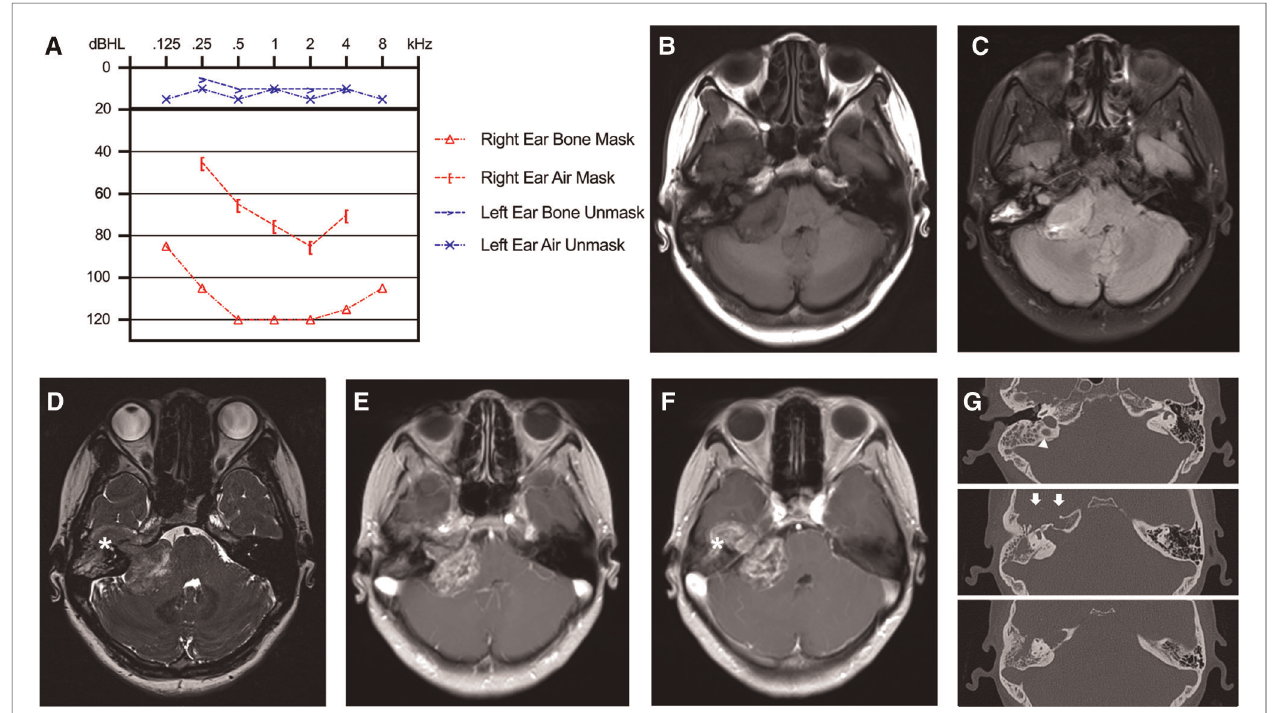
FIGURE 1 | Preoperative hearing and imaging scans. ( A ) Preoperative pure tone threshold audiometry demonstrated profound mixed hearing impairment of the right ear. ( B – F ) MRI scan revealed a mass with a maximal diameter of 5.0 cm at the right cerebellopontine angle with petrous bone invasion. The lesion exhibited low- to iso-intense on T1-weighted images ( B ), iso- to high-intense on T2-FLAIR images ( C ), mixed intense on constructive interference in steady state (CISS) images ( D ), and heterogeneously enhanced after Gd-DTPA administration ( E,F ). ( G ) In the CT scan, we observed an enlargement of the right IAC with signi fi cantly bony destruction of the temporal apex (white arrows) and a slightly high ride of the jugular bulb (white